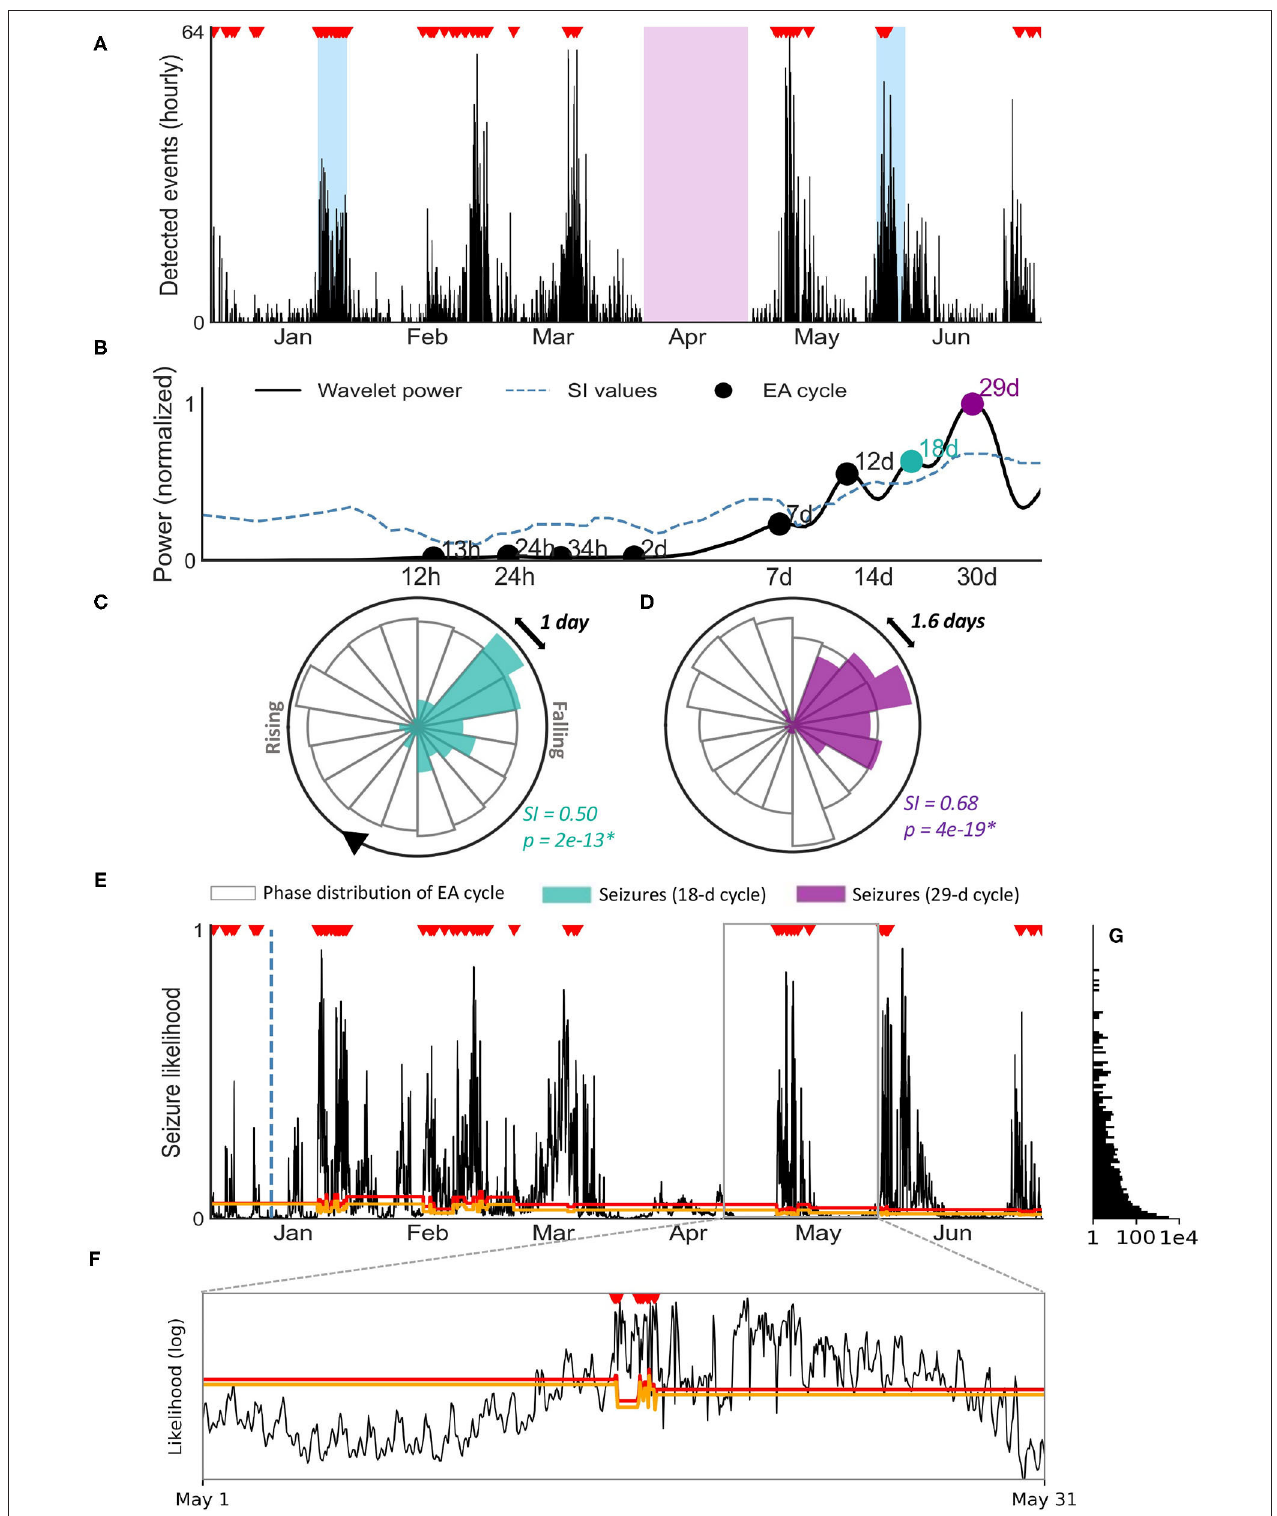
FIGURE 3 | Seizure forecasting case study for patient 1. (A) Hourly rate of machine-learning detected events using the sub-scalp EEG device. Verified seizures (red markers) from manual review of sub-scalp EEG device are shown. The blue regions represent scalp video-EEG assessment periods and the purple region represents a period where the device was removed. (B) Cycle detection in EA using a Morlet wavelet approach. The wavelet spectrum is shown for a range of time periods